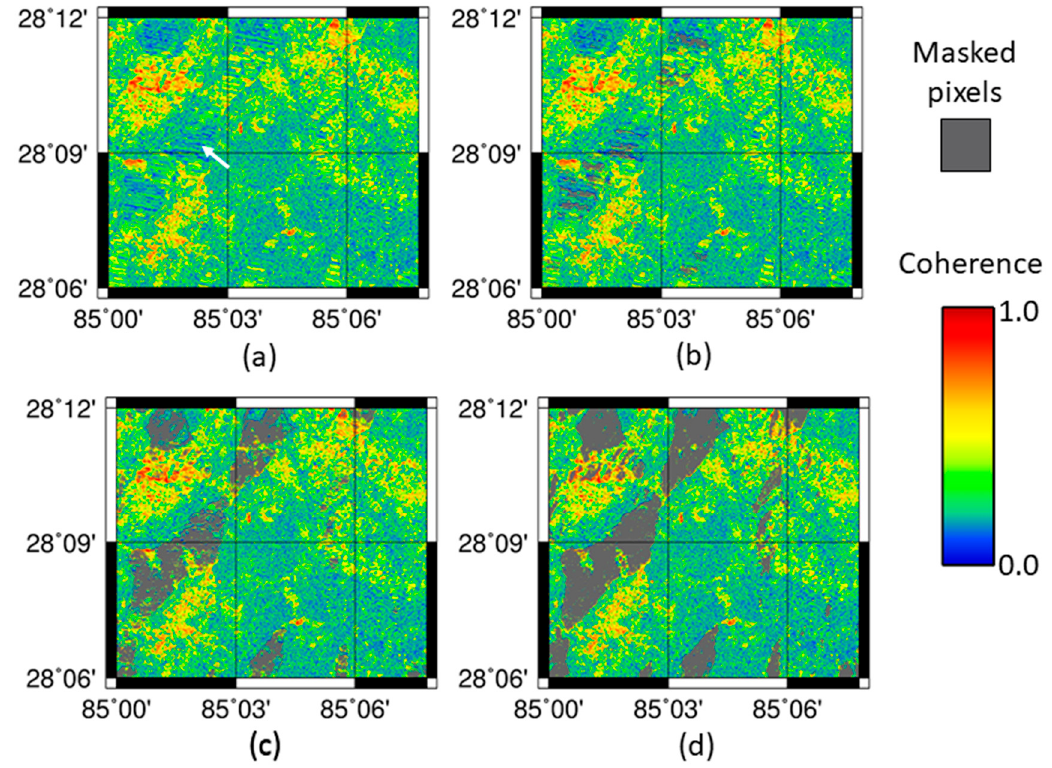
Figure A1 ( a ) Pre-event coherence map for Jharlang with white arrow indicating distorted pixels. ( b , c , d ) The effect of masking pixels for which the contributing area was over 5000, 2000 and 1000 m 2 respectively